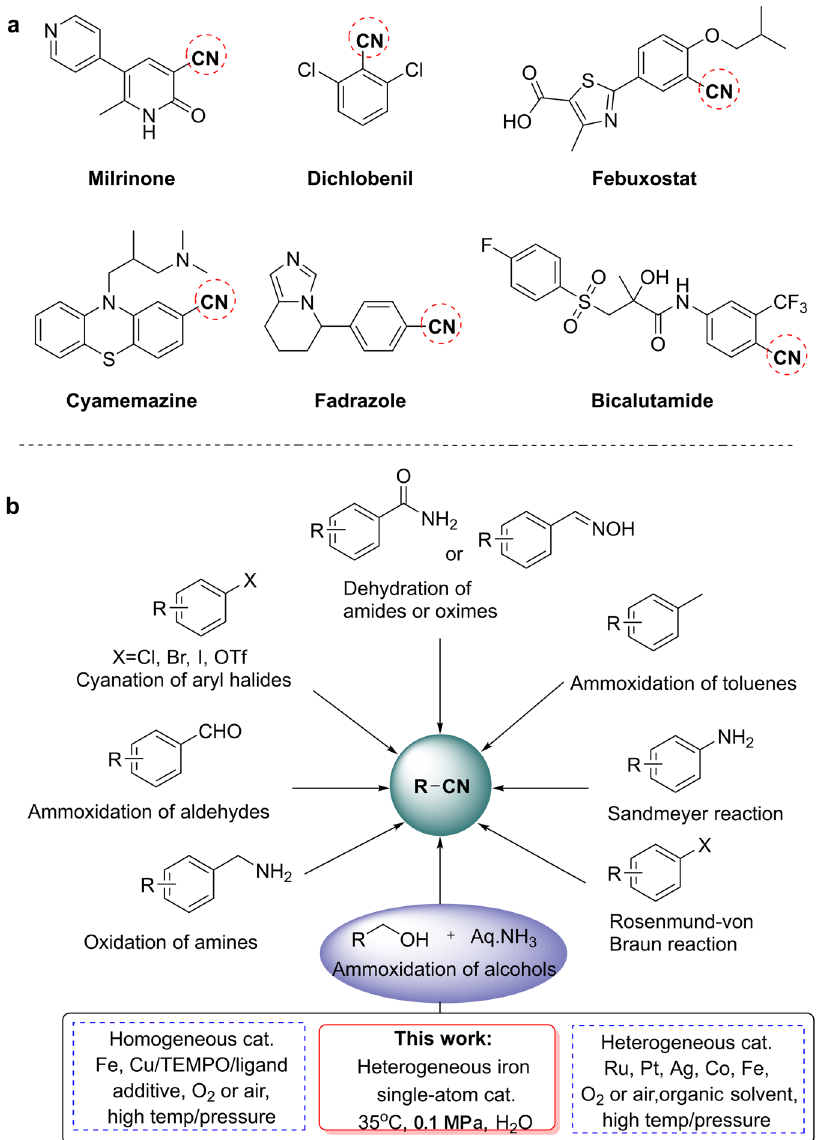
Fig. 1 Concepts. a Selected examples of current drugs and bio-active functionalized nitriles. b strategies for the synthesis of